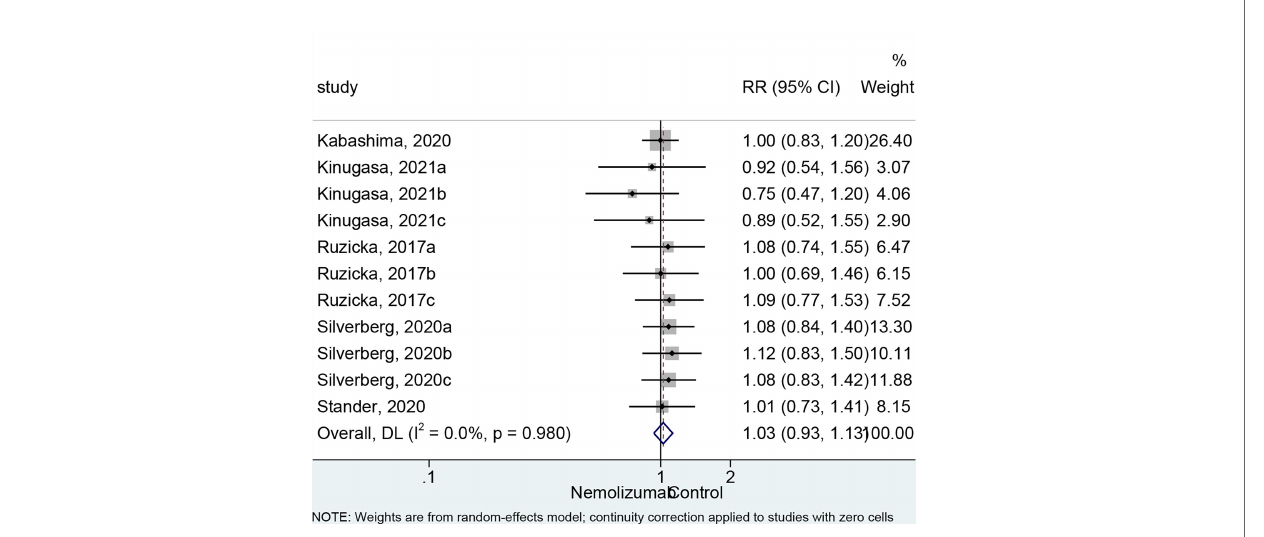
FIGURE 4 | Forest plot of adverse events comparing nemolizumab and